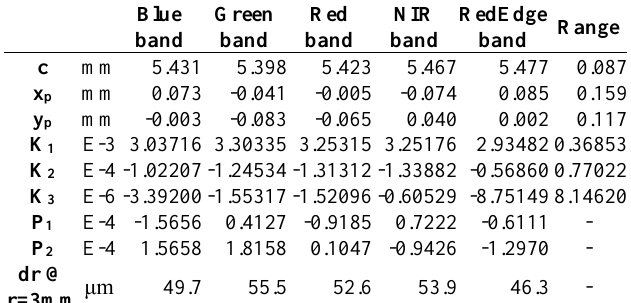
Table 2: Camera calibration parameters for the five bands